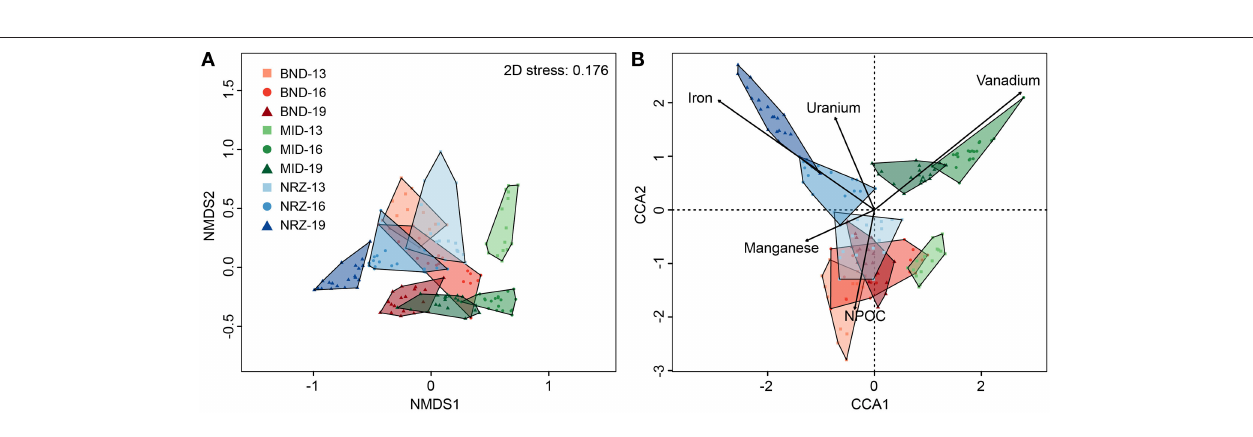
FIGURE 4 | (A) A non-metric multidimensional scaling (NMDS) graph of the microbial community data. Distances between samples indicated in this graph are explained by their Bray-Curtis dissimilarity. (B) A canonical correspondence analysis (CCA) of the microbial community data and key geochemical parameters. Distances in this graph are explained by variation in the provided geochemical parameters. Proximity to the parameter lines indicates co-linearity, while line length represents the magnitude of the effect. For example, NRZ-19 linearizes very closely to iron, due to the oxidation of iron sulfides by dissolved oxygen, and subsequent release of Fe 2 + (aq) in this